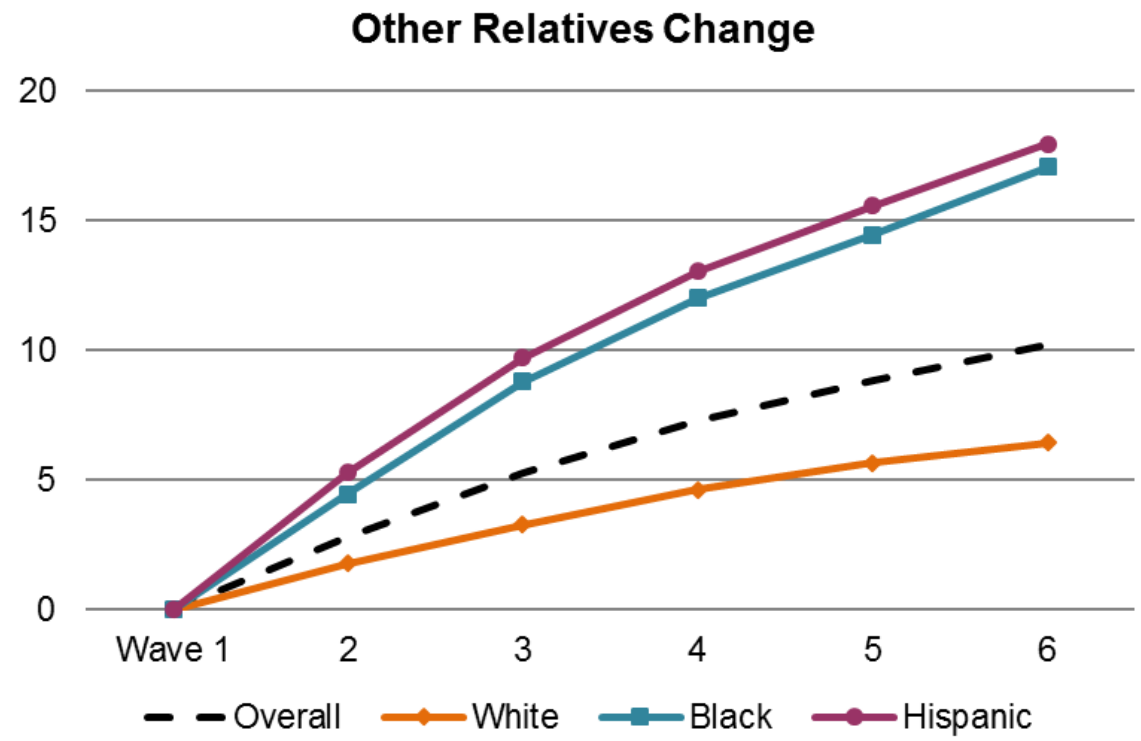
Figure 4: Weighted cumulative percent of children (by race and ethnicity) exposed to other relatives leaving and joining